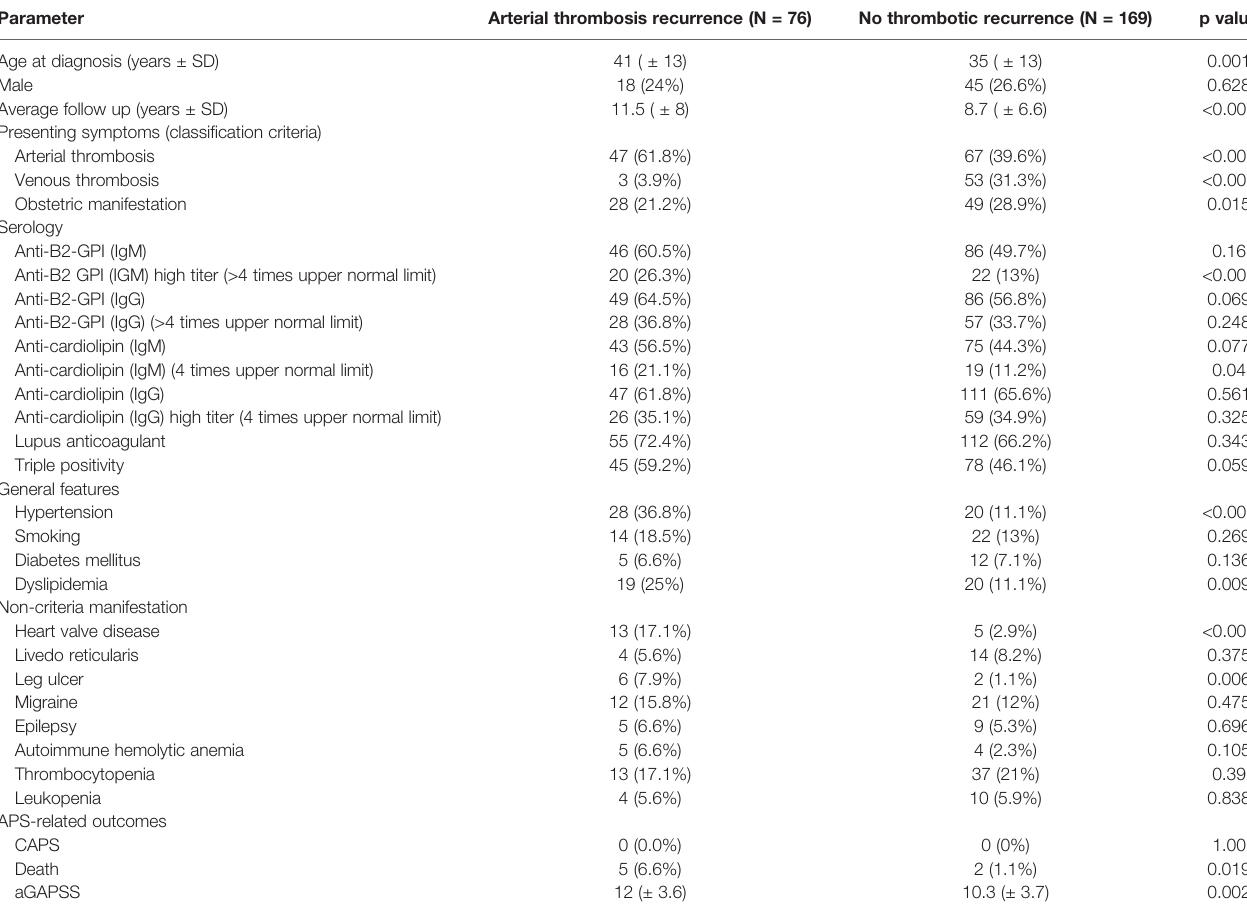
TABLE 2 | Clinical and serological parameters associated with the “ arterial pattern ”